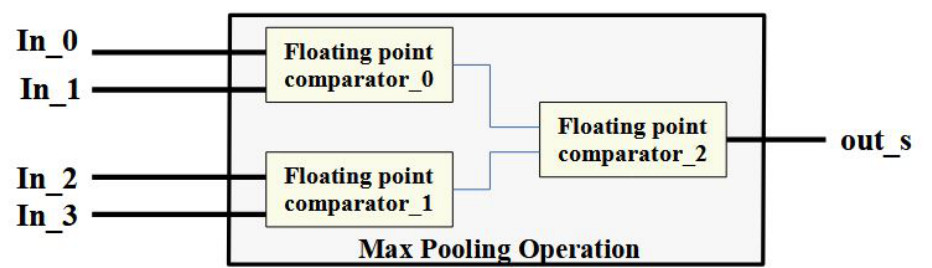
Figure 10. Visual representation of the max pooling using FP comparators.